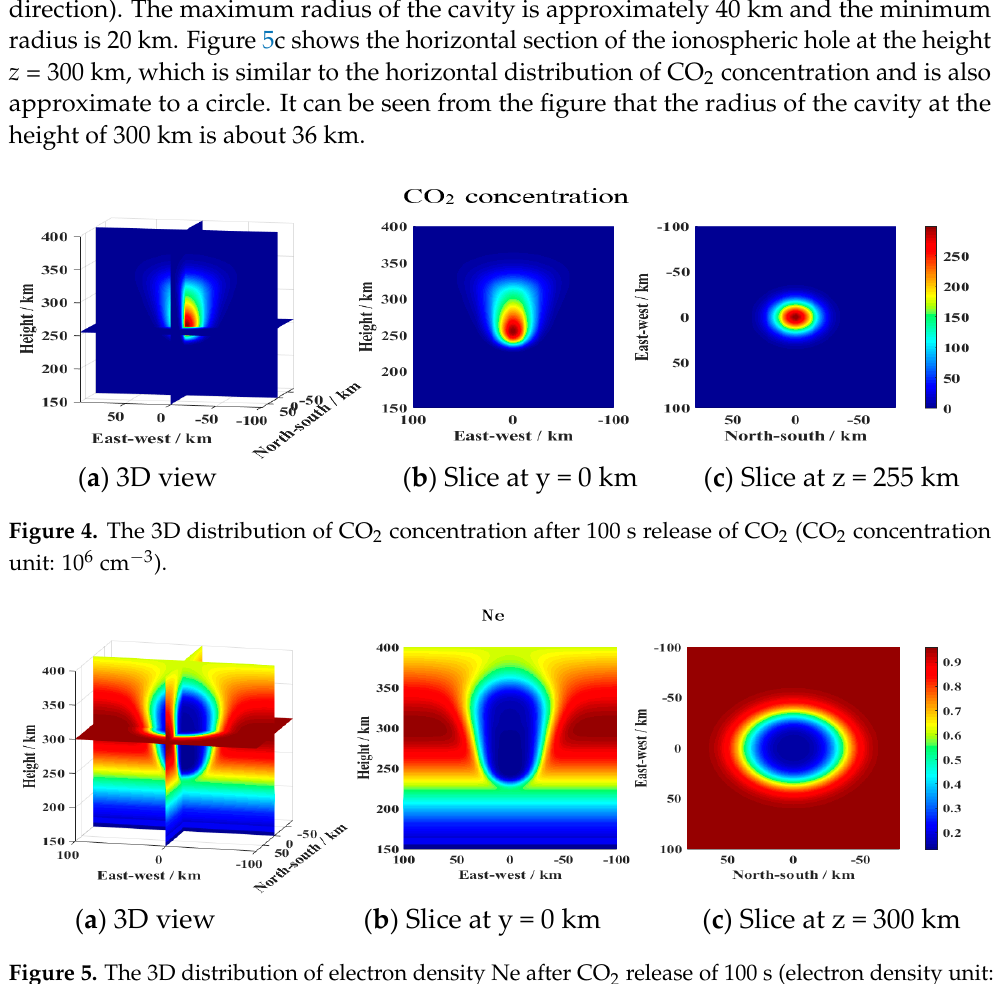
Figure 5. The 3D distribution of electron density Ne after CO 2 release of 100 s (electron density unit: 10 6 cm − 3 ).